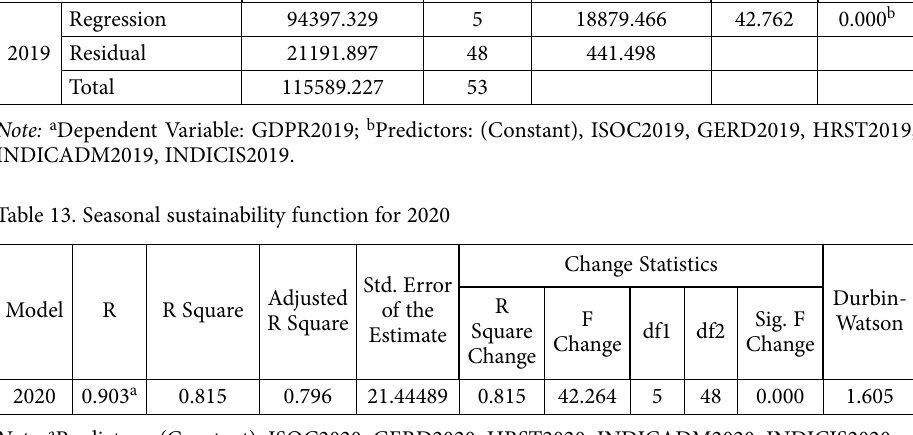
Table 12. ANOVA test of the model for 2019 Model